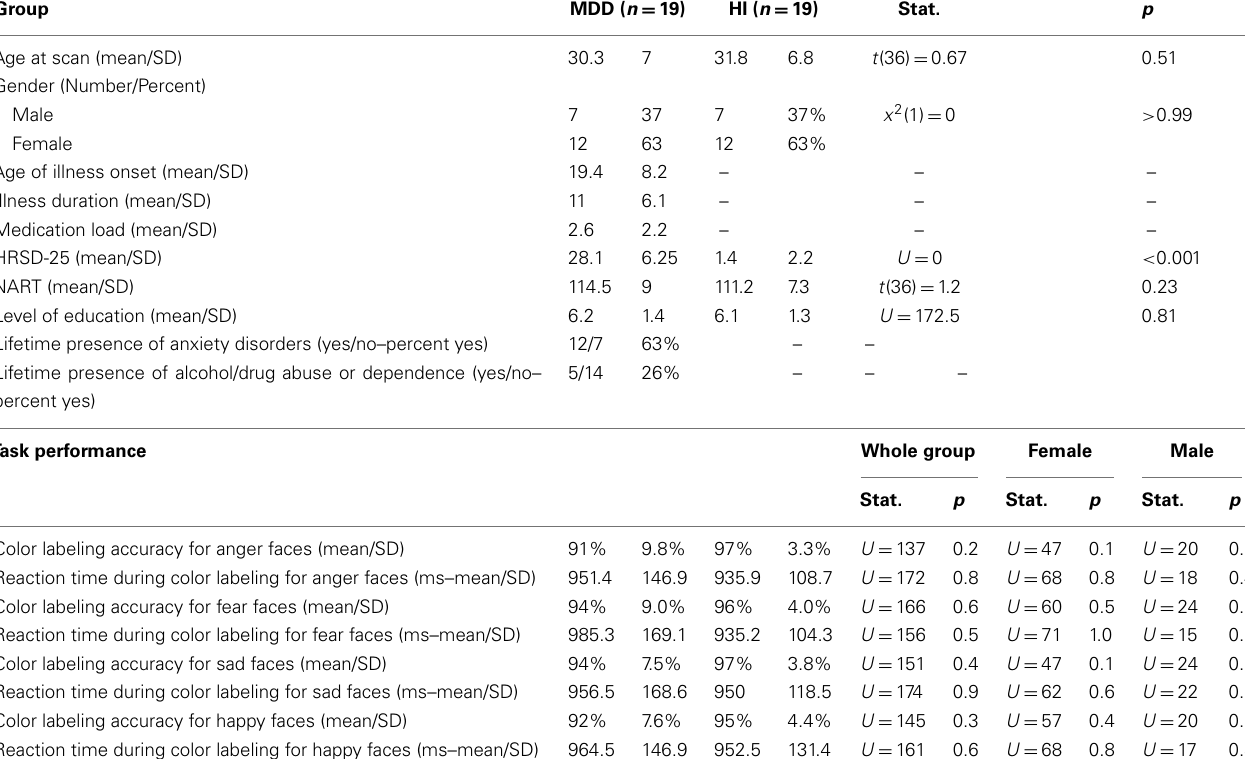
Table 1 | Demographic, clinical variables, and behavior performance.